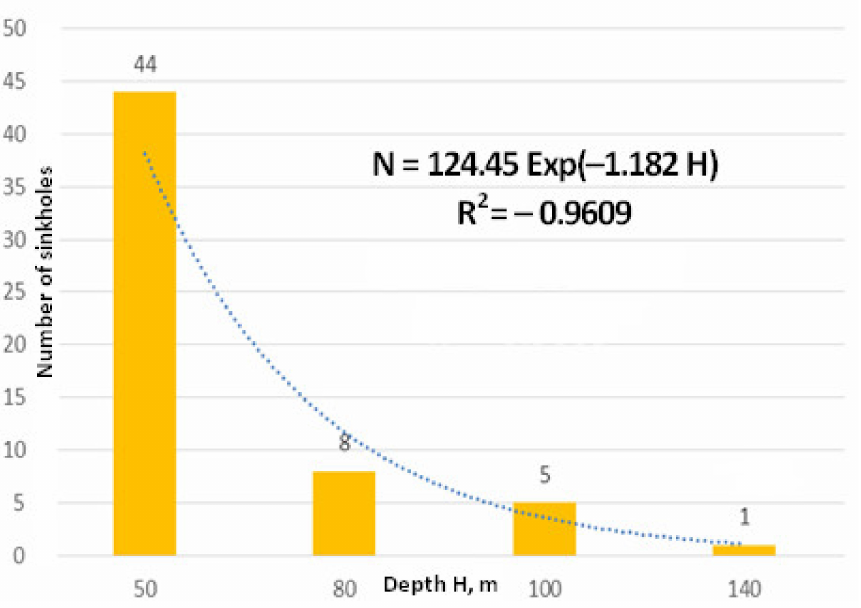
Figure 7. Depth ranges of workings above which sinkholes formed along with the number of observed